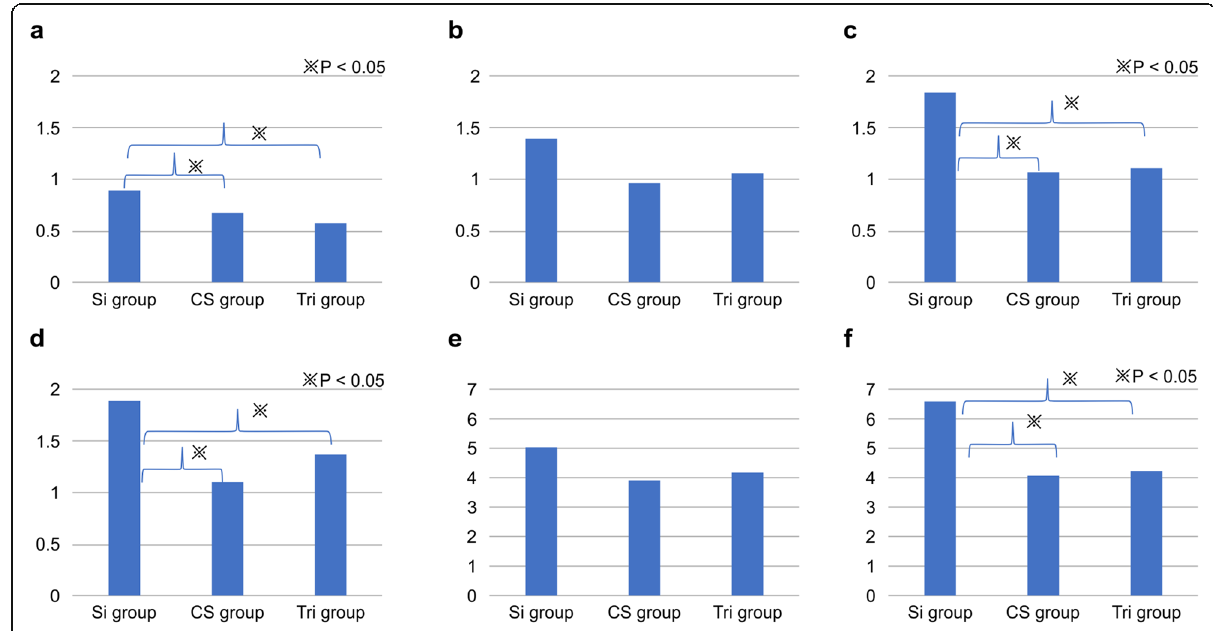
Fig. 5 Accuracy of tooth-supported surgical guides. a Three-dimensional (3D) deviation at the crest in 45. b 3D deviation at the crest in 47. c 3D deviation at the apex in 45. d 3D deviation at the apex in 47. e Angular deviation in 45. f Angular deviation in 47 0.53 ± 0.11 mm, and 0.6 ± 0.13 mm, respectively. The re- Accuracy of the tooth/mucosa-supported surgical guide sults indicated no significant differences. The 3D devia- (Fig. 6) tions at the apex in 45 for the Si, CS, and Tri groups The 3D deviations at the crest in 45 for the Si, CS, and were 0.88 ± 0.06 mm, 0.84 ± 0.22 mm, and 0.79 ± 0.14 Tri groups were 0.44 ± 0.25 mm, 0.48 ± 0.1 mm, and mm, respectively. The results indicated no significant 0.42 ± 0.13 mm, respectively. The results indicated no differences. The 3D deviations at the apex in 47 for the significant differences. The 3D deviations at the crest in Si, CS, and Tri groups were 0.85 ± 0.39 mm, 0.65 ± 0.07 47 for the Si, CS, and Tri groups were 0.84 ± 0.35 mm,